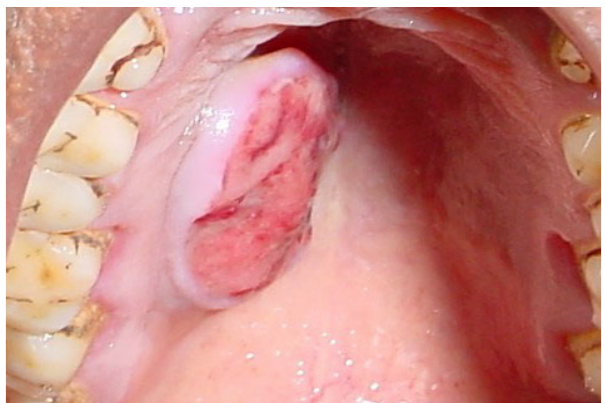
Fig.1- Mass located on the hard palate on the right side with a partly ulcerated overlying mucosa, measuring 2 cm x